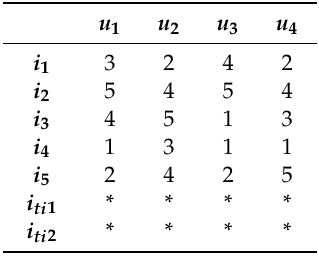
Table 2. Example of user-item rating information table.